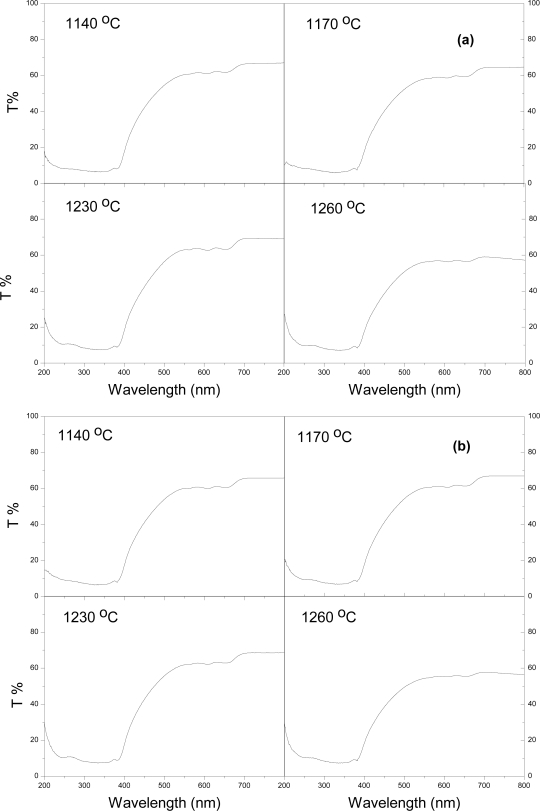
Transmission spectra of ZnO-Bi2O3-TiO2 ceramics after (a) 45 minutes and (b) 90 minutes sintering time.